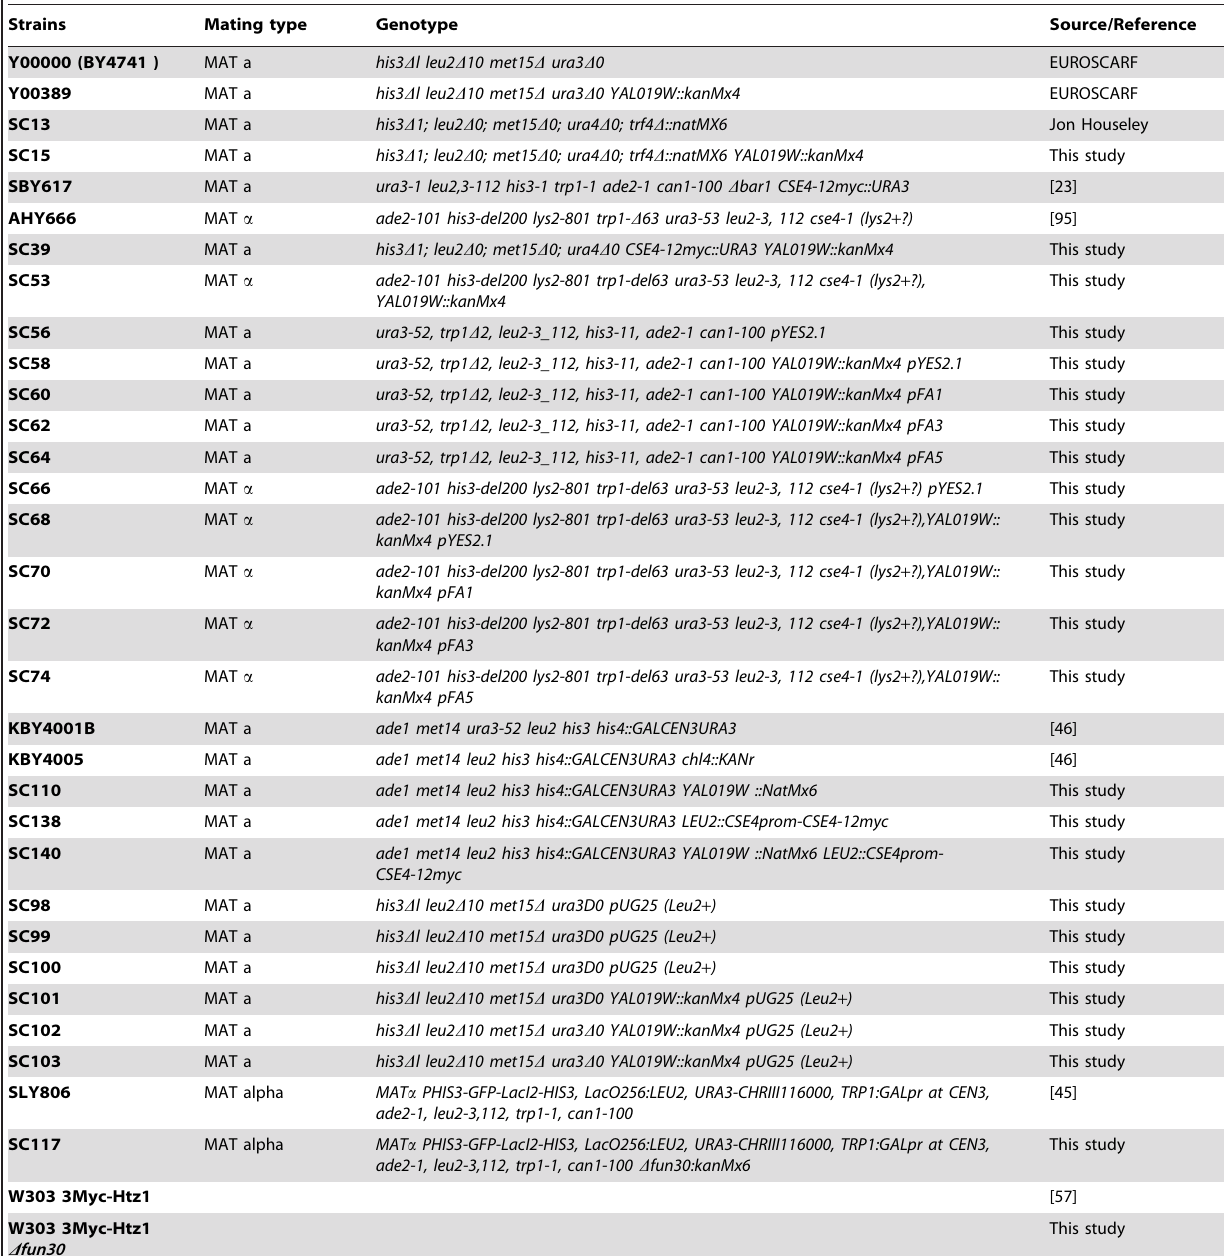
Table 1. S. cerevisiae strains used in this